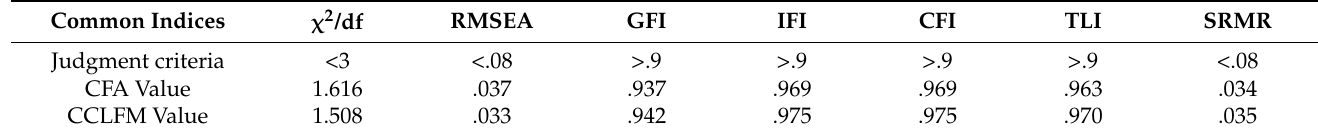
Table 5. Model fitting index comparison results of CFA and